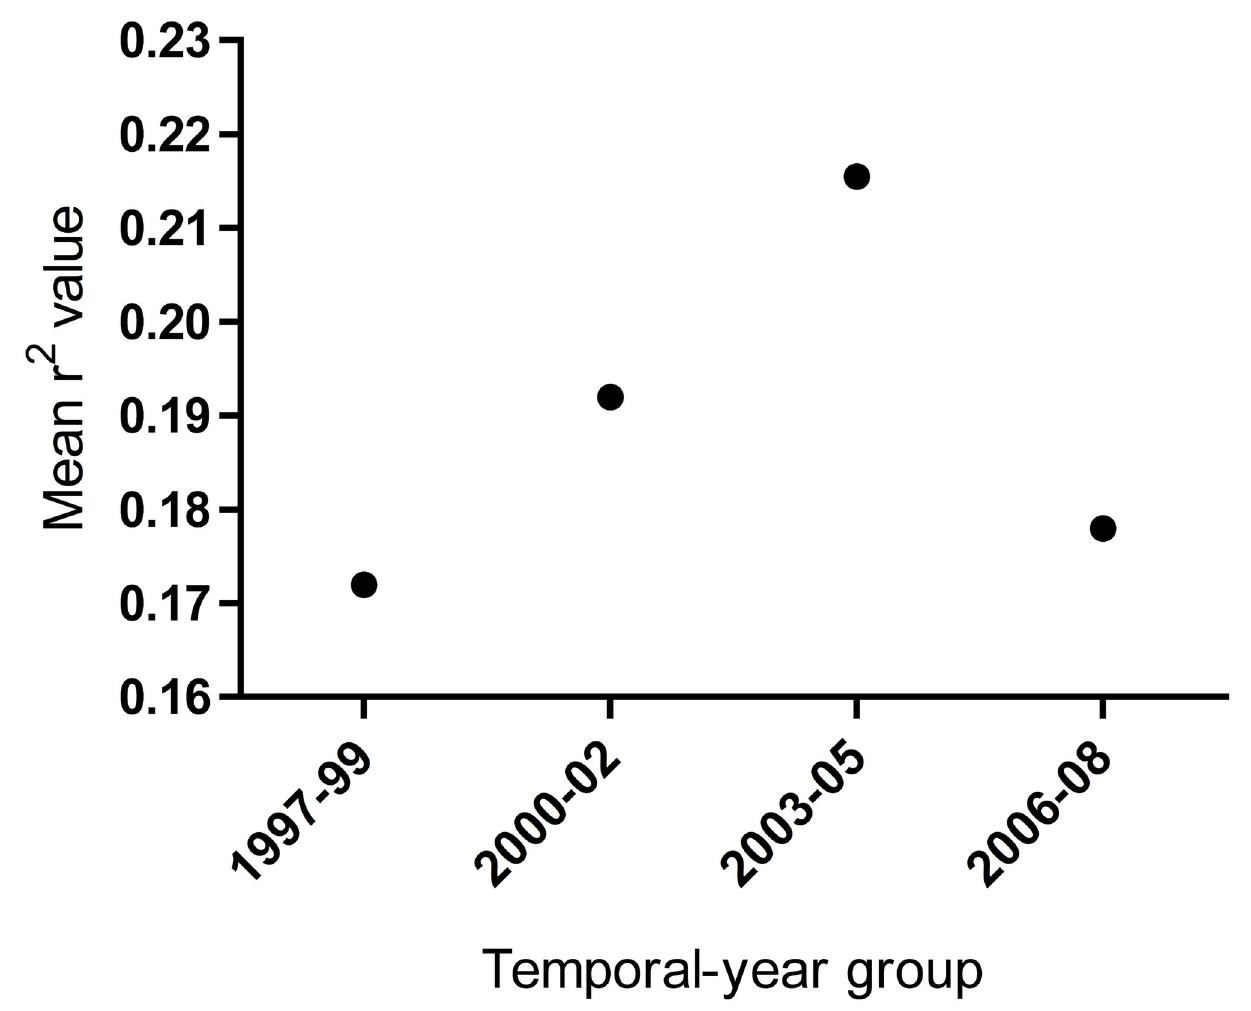
Figure 4. Mean r 2 values of contiguous three-year Mod Waters model predictions. Models based on data from 1997-99 were used to predict data from various temporal-year groups (the same three years, the following three years, and so on). This allowed us to determine whether the models’ ability to predict other data was consistent even as the data being predicted became farther removed temporally from the data the model was created on. Error bars are present, but are so small they are not visible. Though year groups differed significantly, this appears to be due to factors other than temporal distance from the time period that was used to create the model, as it is not a linear